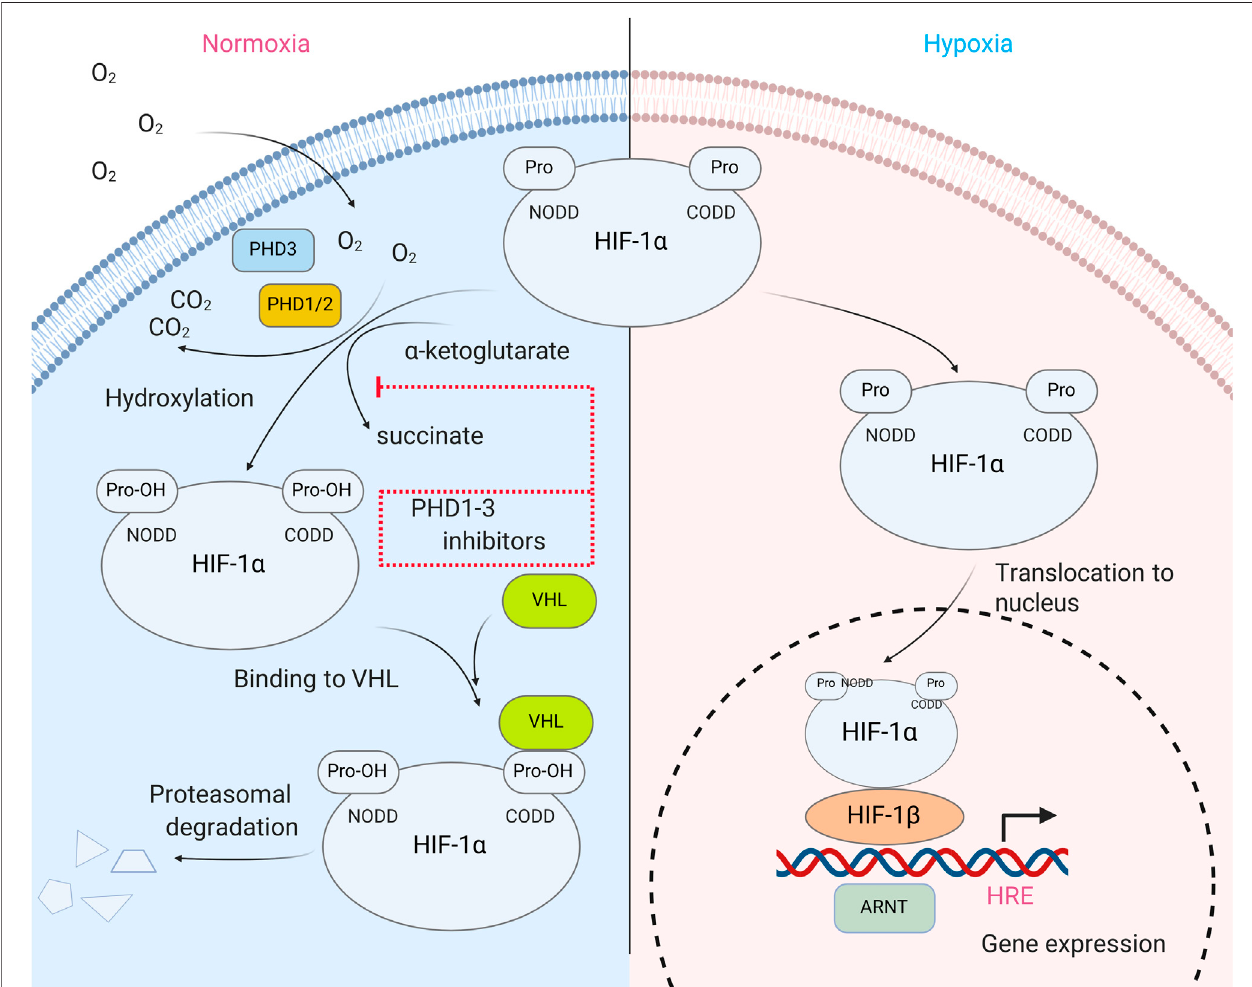
FIGURE 1 | HIF prolyl hydroxylase in HIF stability regulation. In normoxia, HIF α subunit is hydroxylated at Pro 402 and 564 via reaction catalyzed by isoenzymes of HIF prolyl hydroxylase (PHD1-3). Hydroxylated prolines are recognized by VHL protein, a component of ubiquitin ligase complex, and thus, eventually target HIF for degradation. In hypoxia, PHD activity is strongly reduced, which results in HIF α protein stabilization, its dimerization with HIF β subunit and translocation to the nucleus, where HIF dimer binds on the enhancer sequence of HIF target genes and activates gene